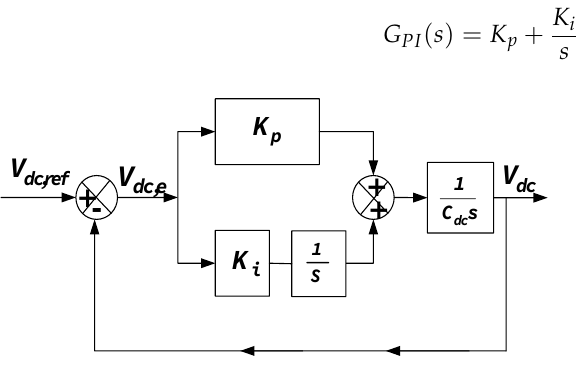
Figure 4. Regulation of DC-link Voltage. The overall open-loop and closed-loop transfer function of the dc-link voltage compensator ( G V (𝑠) and 𝐻 (𝑠) ) are computed as